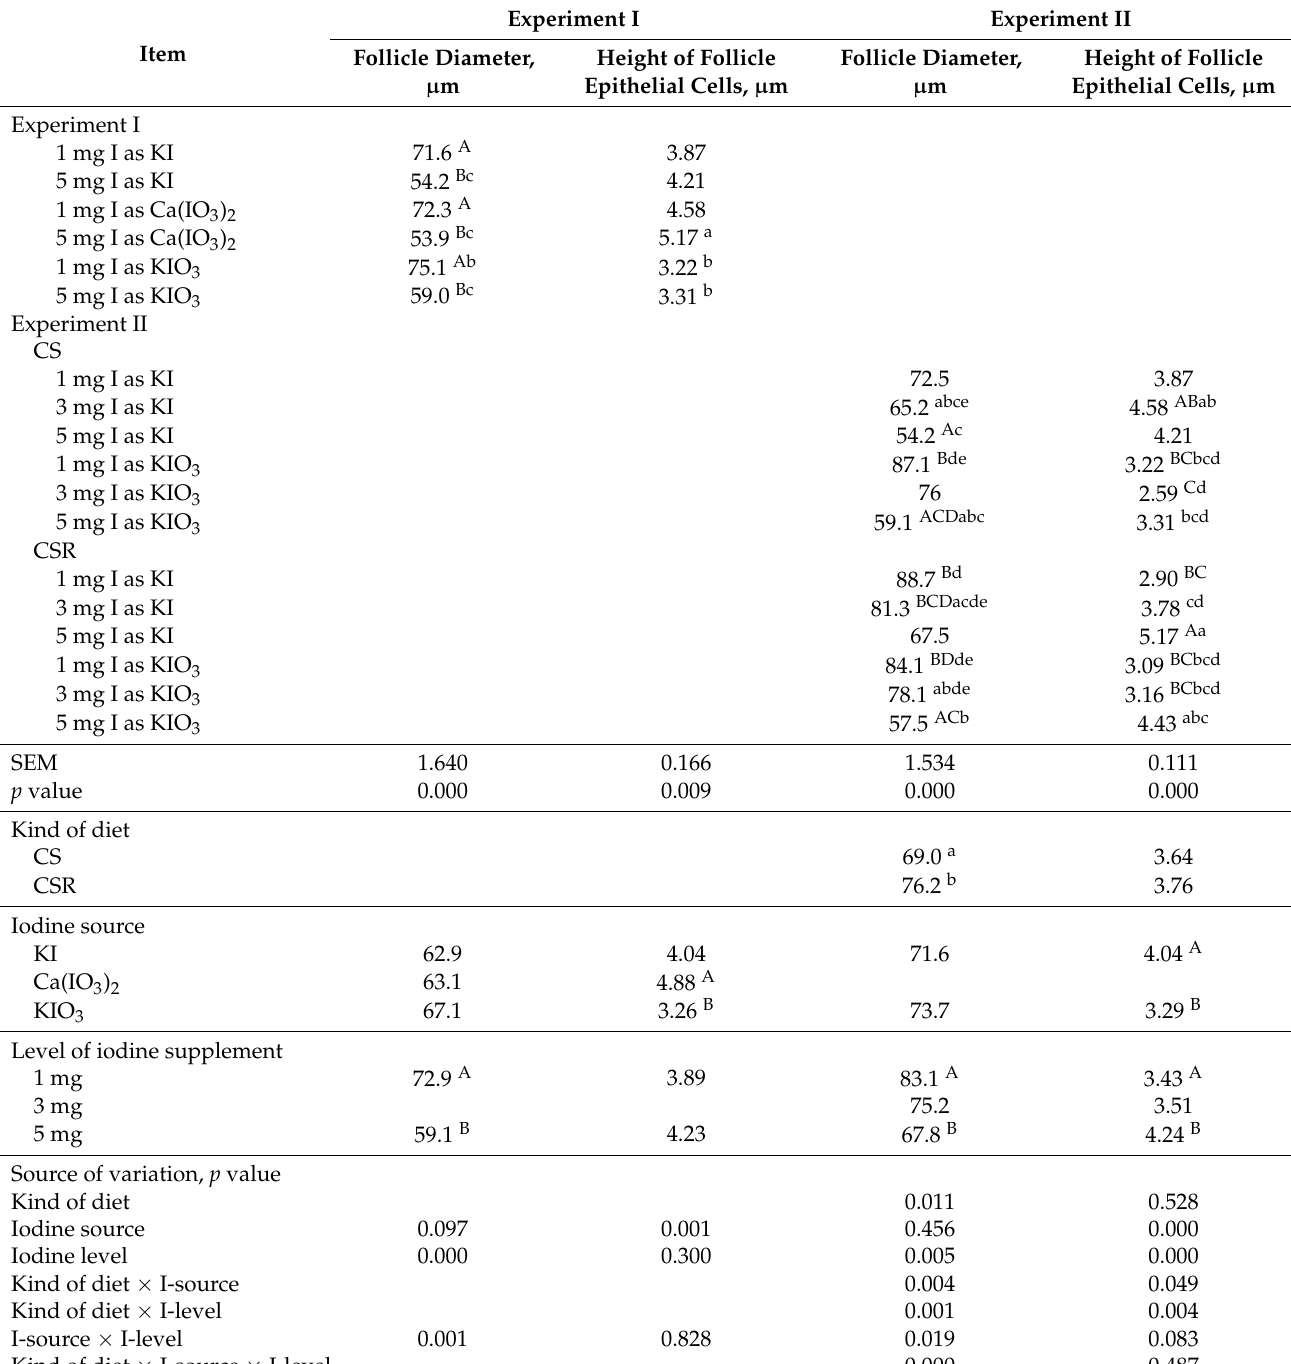
Table 4. Morphometric characteristic of the thyroid gland (Exp. I and Exp.